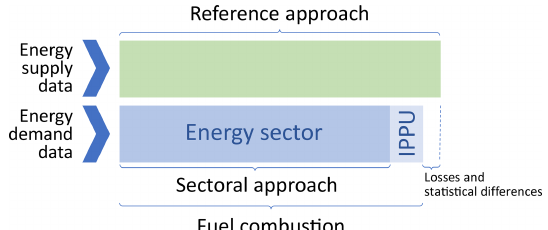
Figure 2. Schematic explanation of the IEA’s emissions estimate totals. The IEA reports emissions from fuel combustion, using a reference approach, based on energy supply-side data (production, trade, stock changes), and a sectoral approach, based on energy demand-side data (largely sales). The latter is also subdivided be- tween emissions that fall under the IPCC’s energy sector and those that fall under the industrial processes and other product use (IPPU) sector (largely in the metal